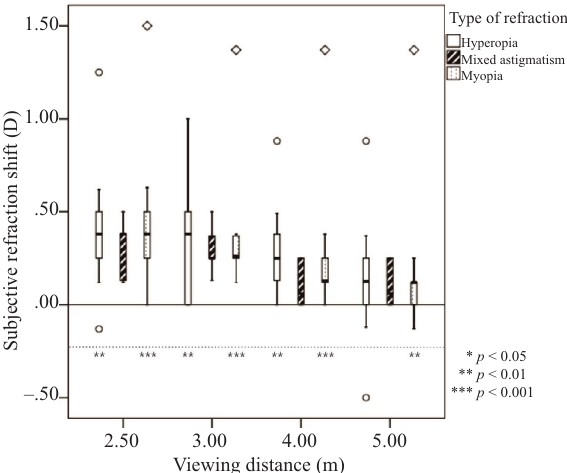
Fig. 1. The refraction shifts (the difference between subjective